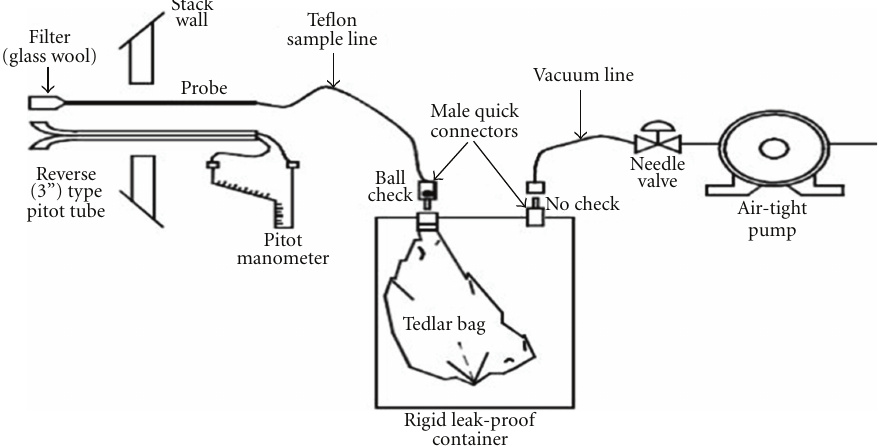
Figure 1: Diagram of greenhouse gas sampling system.